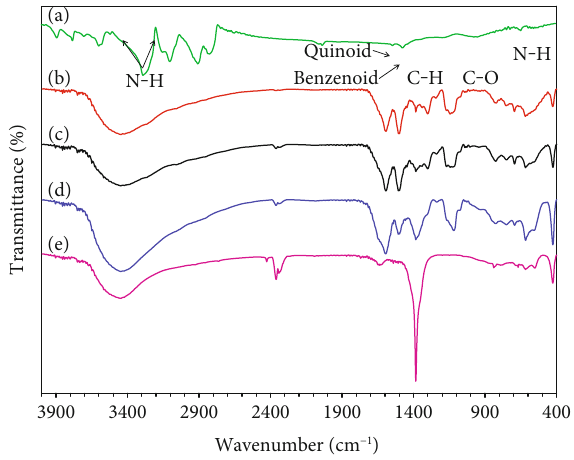
O (a), MHT (b), and HT 3 4